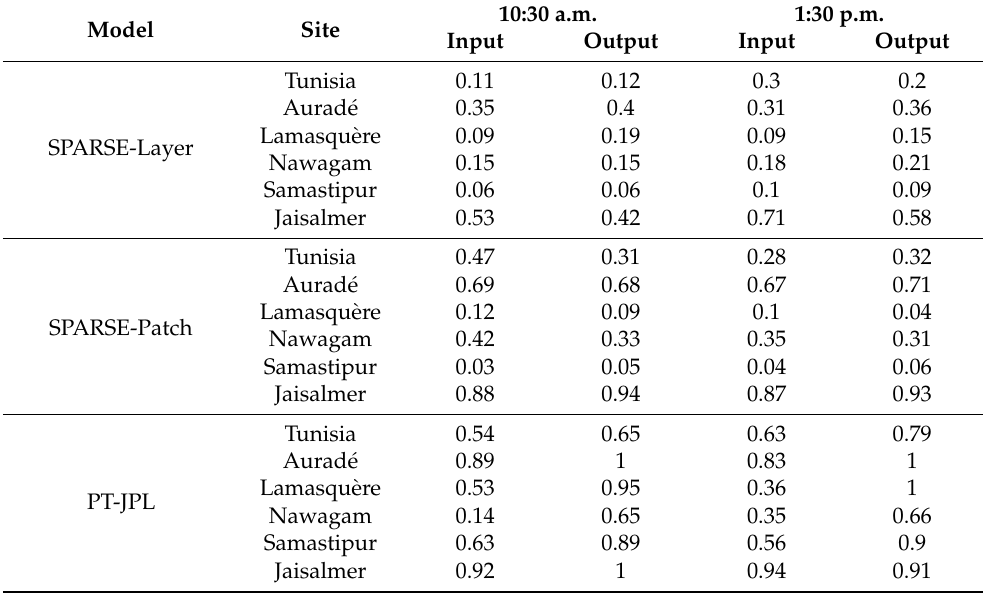
Table 4. E/ET ratio estimated with the SPARSE and PT-JPL models using the two aggregation approaches. 10:30 Model Site